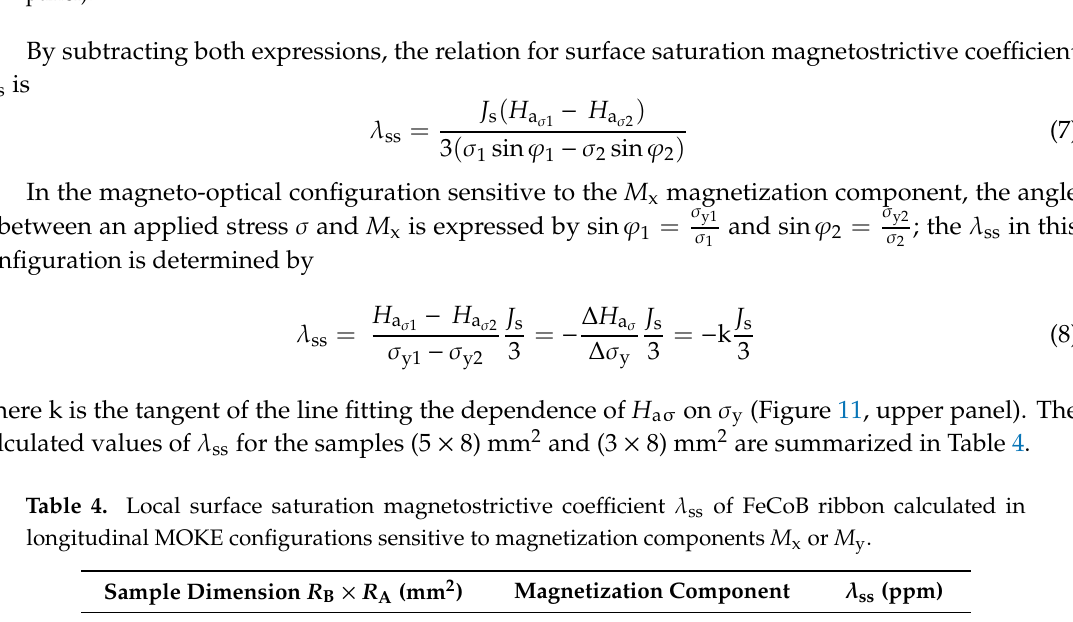
Figure 11. Measured anisotropy magnetic field H a σ of FeCoB ribbon depicted as a function of applied stress σ x ( σ y ) in longitudinal MOKE configurations sensitive to M x (upper panel) and to M y (lower panel).